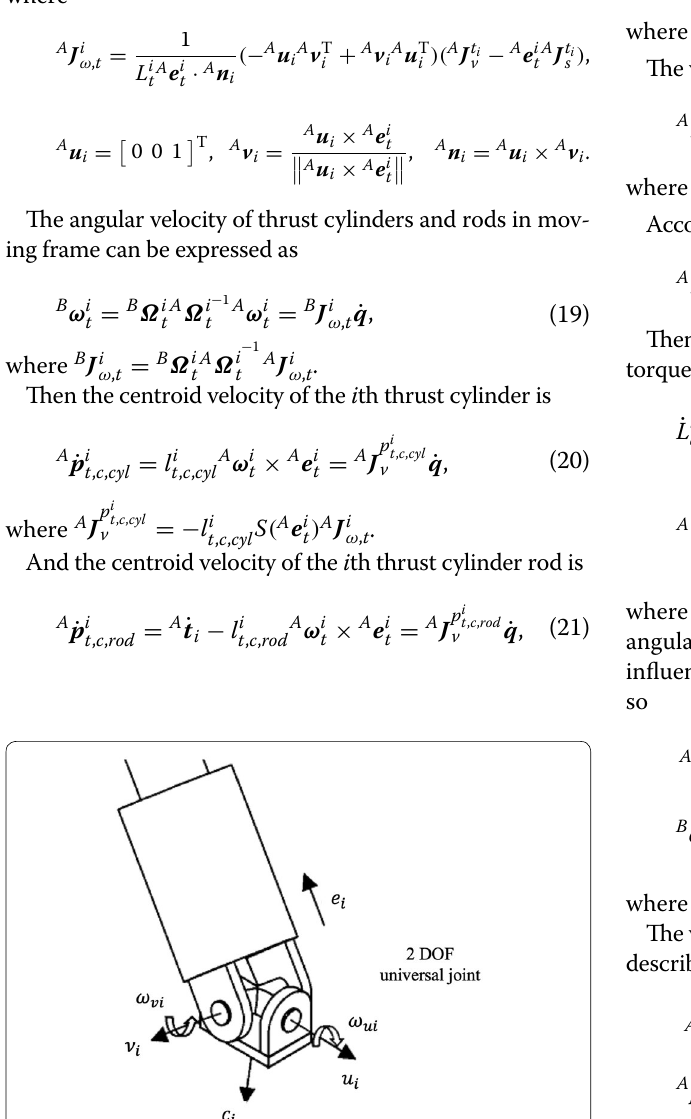
Figure 6 Structure of universal